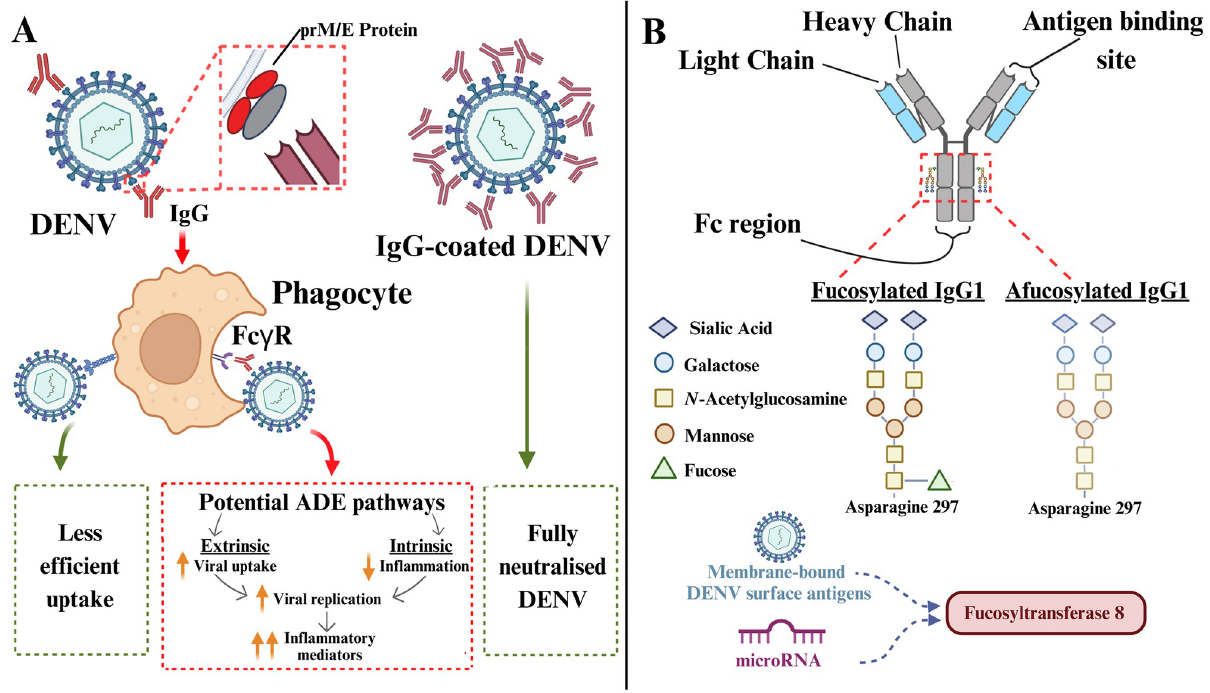
Fig 1. Schematic representation of IgG antibodies and the interaction with DENV. ( A ) Anti-DENV IgGs can bind to DENV antigens including PrM and E proteins, which promotes interaction with Fc γ Rs, such as Fc γ RI (CD64), Fc γ RII (CD32), and Fc γ RIII (CD16), expressed by phagocytes. When these antibodies are insufficient to neutralise the DENV, this may then result in enhanced immature virion uptake into the phagocytes (extrinsic pathway). In the phagocytes, the suppression of a pro-inflammatory response and induction of a Th2-type immune response can further enhance viral replication (intrinsic pathway), and subsequently cause excessive cytokine production. Together, this process is termed as antibody-dependent enhancement. On the other hand, in the absence of IgG, DENV is taken into the phagocytes less efficiently through canonical receptor-mediated endocytosis and is unlikely to contribute to ADE. When neutralising anti-DENV IgGs are present at high levels, DENV is fully neutralised and severe pathology can be prevented. ( B ) IgG is often depicted as a “Y-shaped” molecule consisting of two identical light chains and two identical heavy chains. The antigen-binding site recognises specific antigens, while the Fc region can engage with Fc γ R expressed by immune cells, leading to activation of effector mechanisms. A posttranslational modification in the Fc region results in the catalysation of a fucose moiety at the asparagine 297 site via FUT8. Afucosylated IgGs lack the fucose structure and have increased binding affinity towards Fc γ RIII. So far, only afucosylated IgG1s have been reported in dengue patients. The stimuli that trigger IgG1 afucosylation in dengue are not well understood, but DENV surface antigens and microRNAs may play a role in the process by modulating FUT8 expression. ADE AU : AbbreviationlistshavebeencompiledforthoseusedinFigs 1 and 2 : Pleaseverifythatallentriesarecorrect : , antibody-dependent enhancement; DENV, dengue virus; E, envelope; Fc γ R, Fc γ receptor; FUT8, fucosyltransferase 8; IgG, immunoglobulin G; PrM,